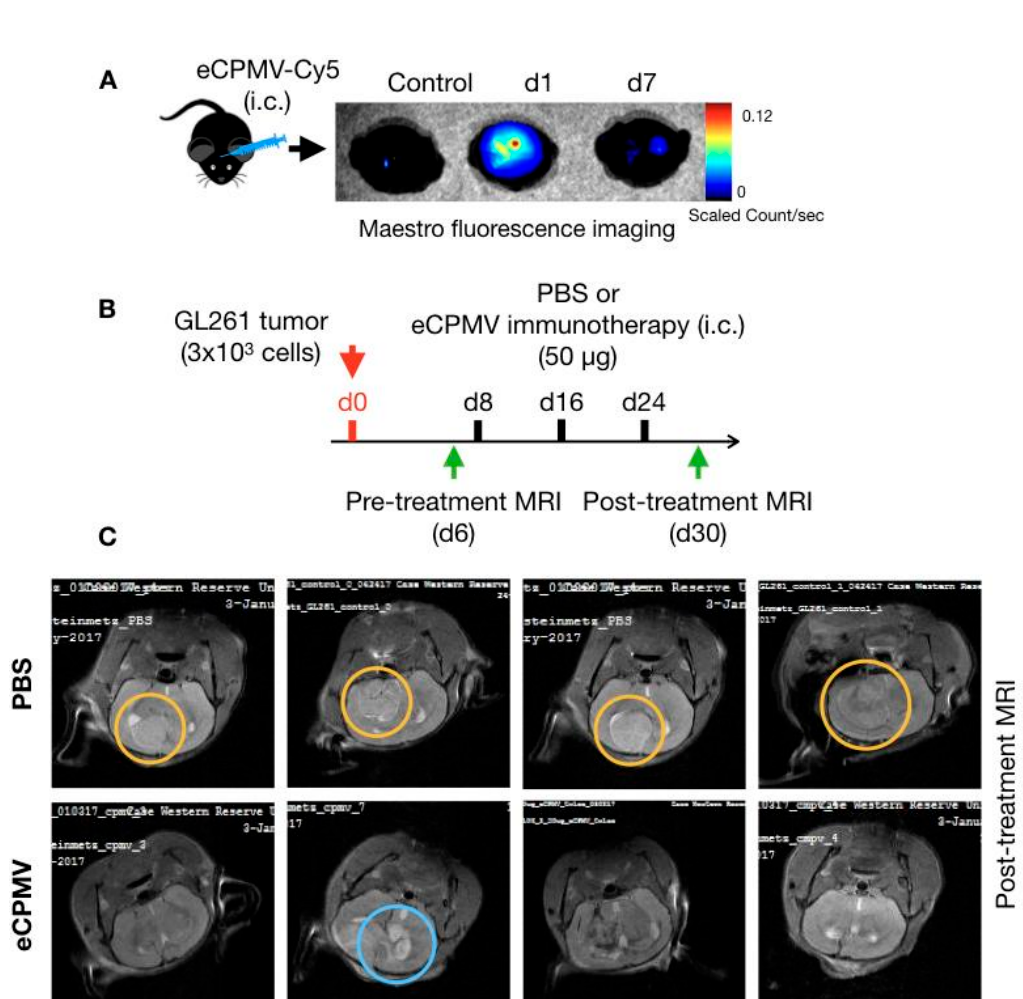
Figure 2. Intracranial eCPMV injection and immunotherapy. ( A ) eCPMV retention in brain following intracranial administration was determined using eCPMV-Cy5 and Maestro fluorescence imaging system. ( B ) For in situ immunotherapy, C57BL6 mice ( n = 4) were inoculated with 3 × 10 3 GL261 cells intracranially and administered PBS or eCPMV via intracranial injections on days 8, 16 and 24. ( C ) On day 30, MRI imaging (7 Tesla) was used to visualize glioma post-treatment. Yellow circles highlight solid tumors in PBS administered mice, whereas blue circle highlights the residual tumor and / or edema in one of the mice in the eCPMV treatment group.